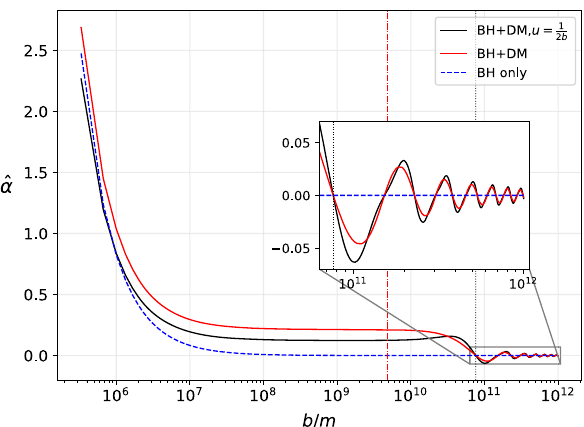
(31) Fig. 4 Curve of the weak deflection angle in the SFDM profile for different values of the dimensionless impact parameter b / m in Sgr. A*. The vertical dotted line is the value of the outermost core radius r c ∼ 7 . 639 × 10 10 m . The region below the dash-dotted vertical line is the cusp region ( ∼ 4 . 86 × 10 9 m )